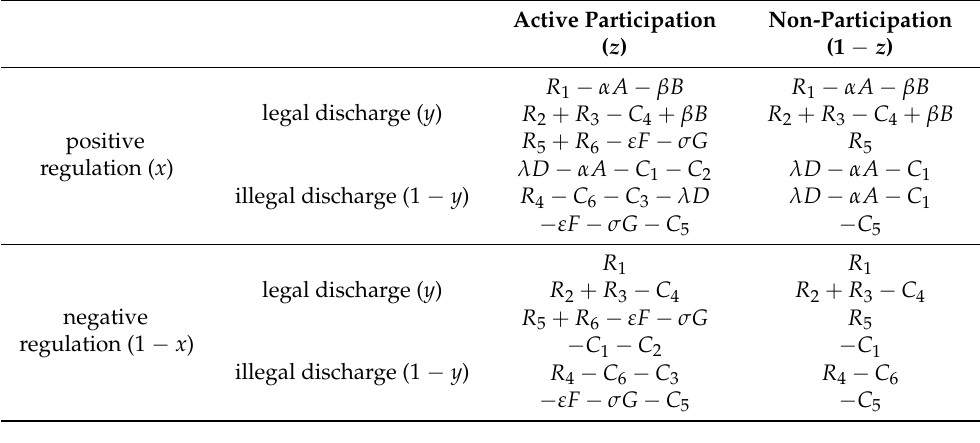
Active Participation ( z )